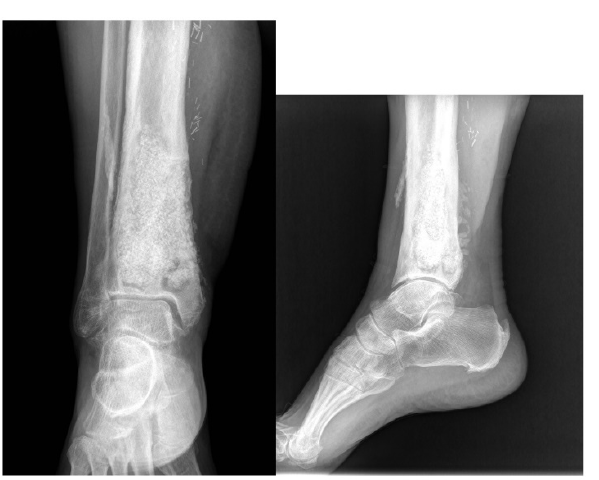
Figure 5. A. Small posteromedial cavity not filled with bioglass B. Second cavity is independent of main cavity.